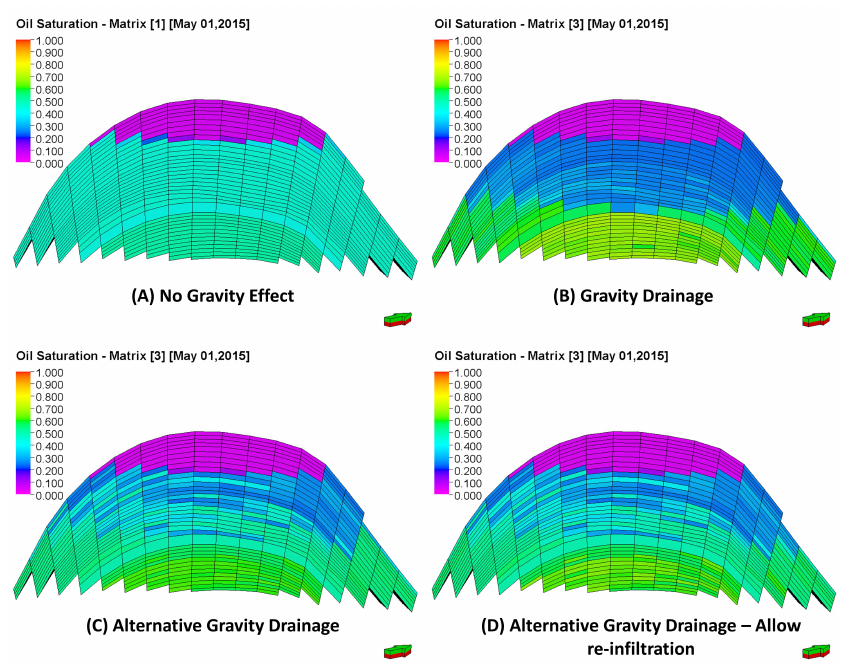
Figure 17. Comparison of the oil saturation profile using different formulas of gravity drainage; ( A ) No gravity effect, ( B ) Gravity drainage, ( C ) Alternative gravity drainage, and ( D ) Alternative gravity drainage–allow re-infiltration.